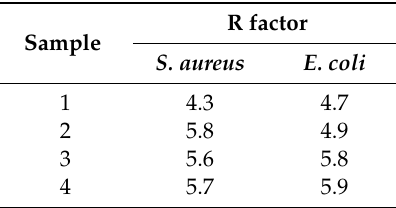
Table 3. Bacterial contact-killing e ffi cacy determined by Japanese industrial standard JIS Z2801:2000 against: S. aureus and E. coli